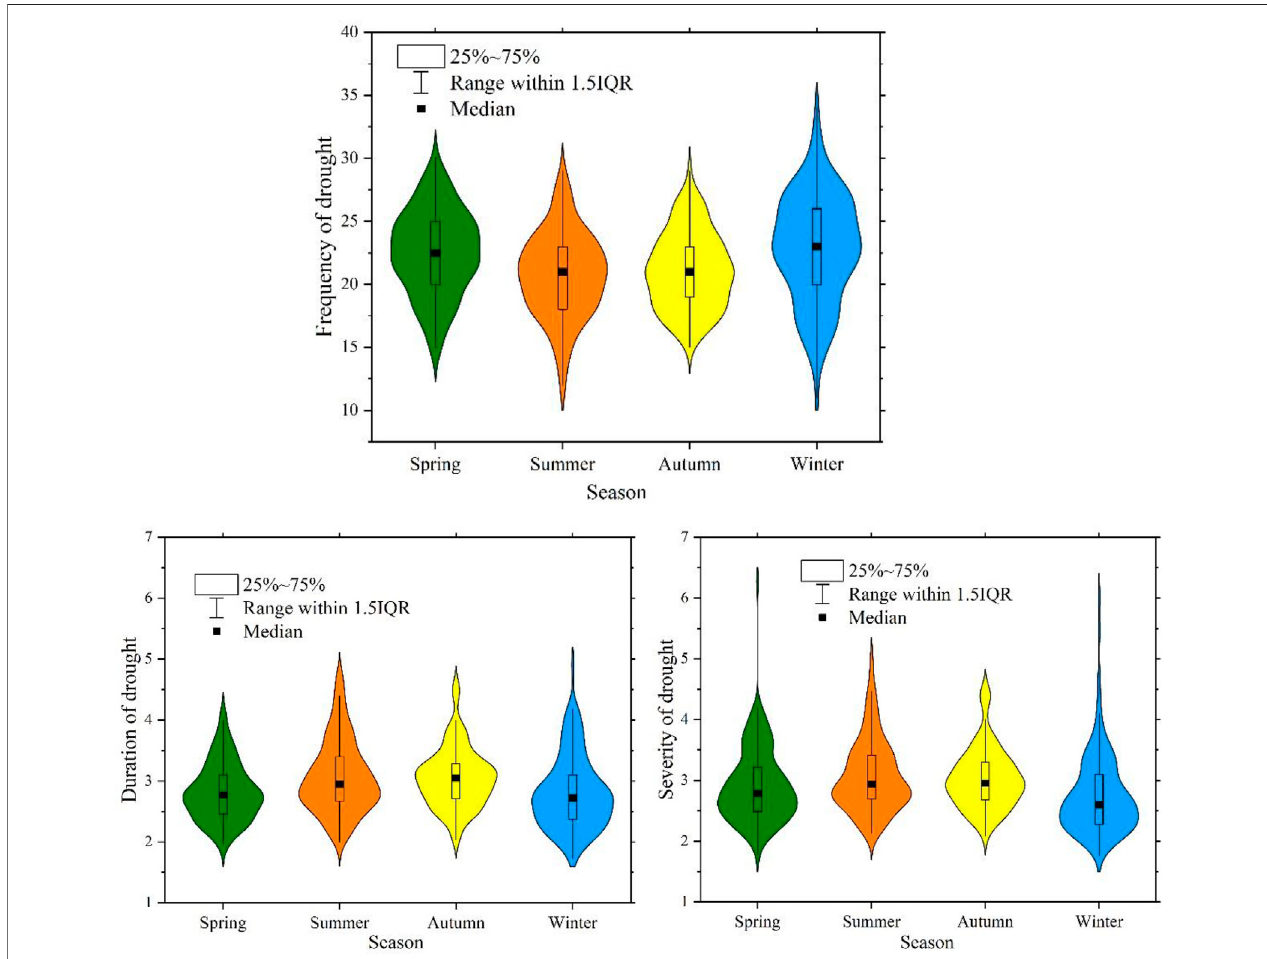
FIGURE 11 | Statistics of seasonal drought variables of 122 meteorological stations.